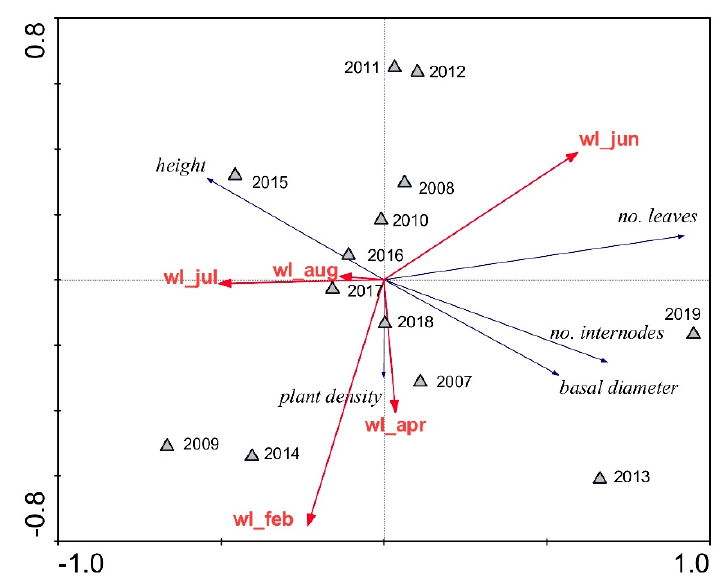
Figure 4. Redundancy analysis plot showing the strengths of the associations between monthly water